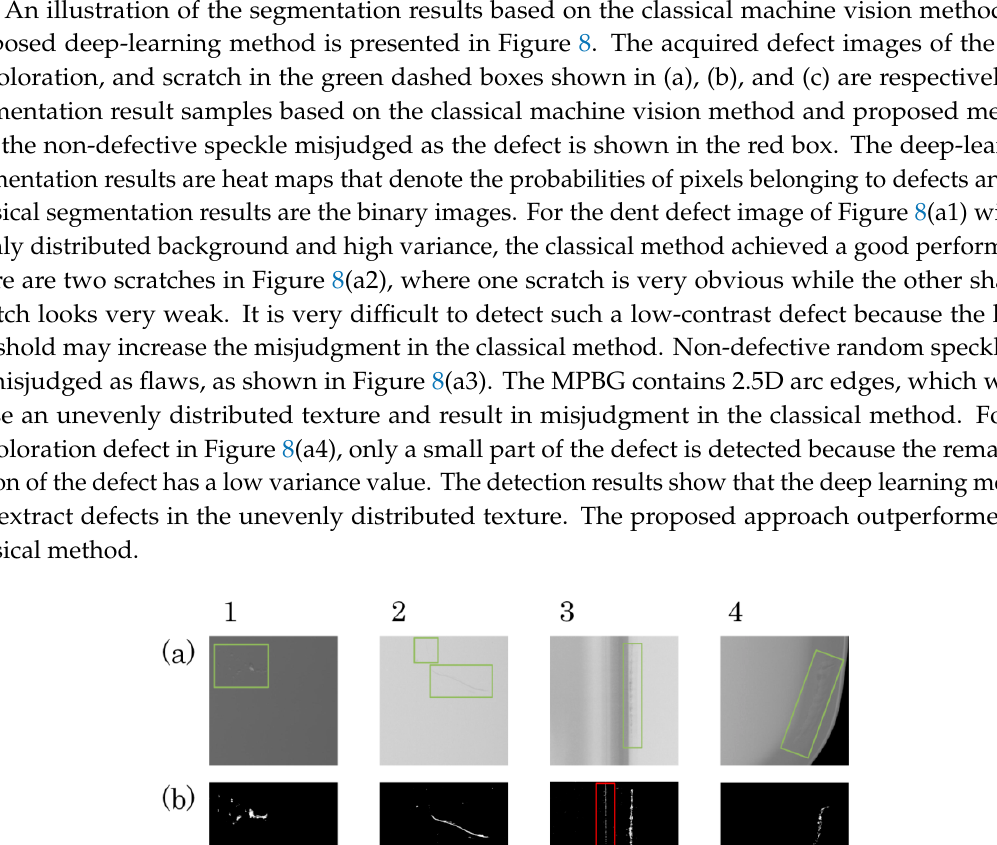
Figure 9. Segmentation results of scratch defects and dent defects: ( a , b ) are the respectively acquired defect images and segmentation results of scratch defects; ( c , d ) are the respectively acquired defect images and segmentation results of dent defects.